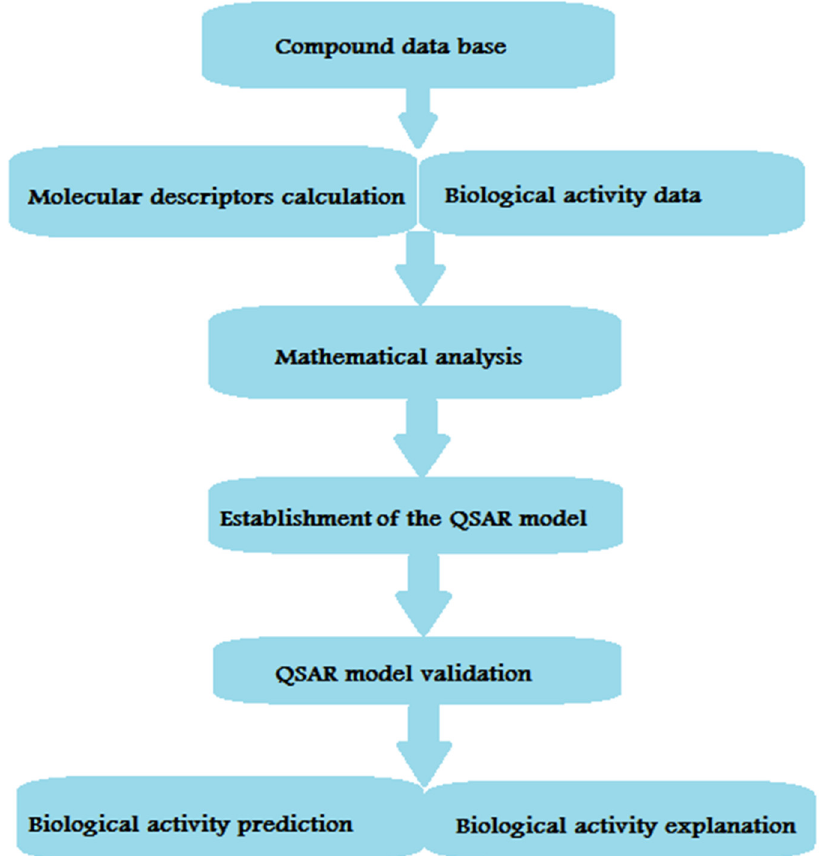
Figure 2. Main steps involved in the development of a QSAR model.